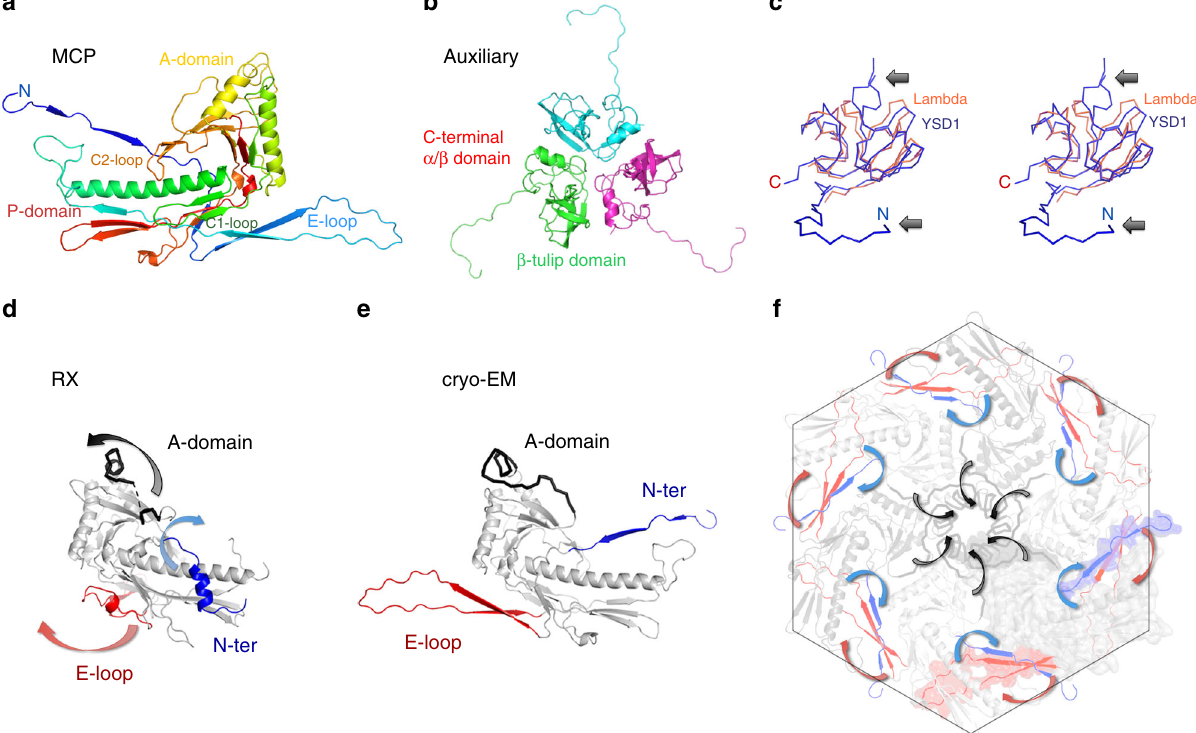
Fig. 2 The major capsid and auxiliary proteins. a Cartoon representation of the major capsid protein with blue – red gradient from N- to C-terminus. b The auxiliary protein is a homotrimer composed of two domains with a β -tulip fold and an N-terminal hook. c Wall-eyed stereo image of the homologous λ cementing protein, gpD (PDB ID 1C5E, orange) aligned with YSD1_16 (blue). Arrows highlight the two main differences in the N-terminal region and β -tulip domain. d , e Cartoon representations of the major capsid protein structures (grey) derived from a crystal structure of the monomeric protein (RX, d ) and the cryo-EM reconstruction ( e ). Conformational switches of the E-loop, N-ter and A-domain regions are highlighted by arrows. f Hexon capsomer in the cryo-EM structure of the icosahedral head.